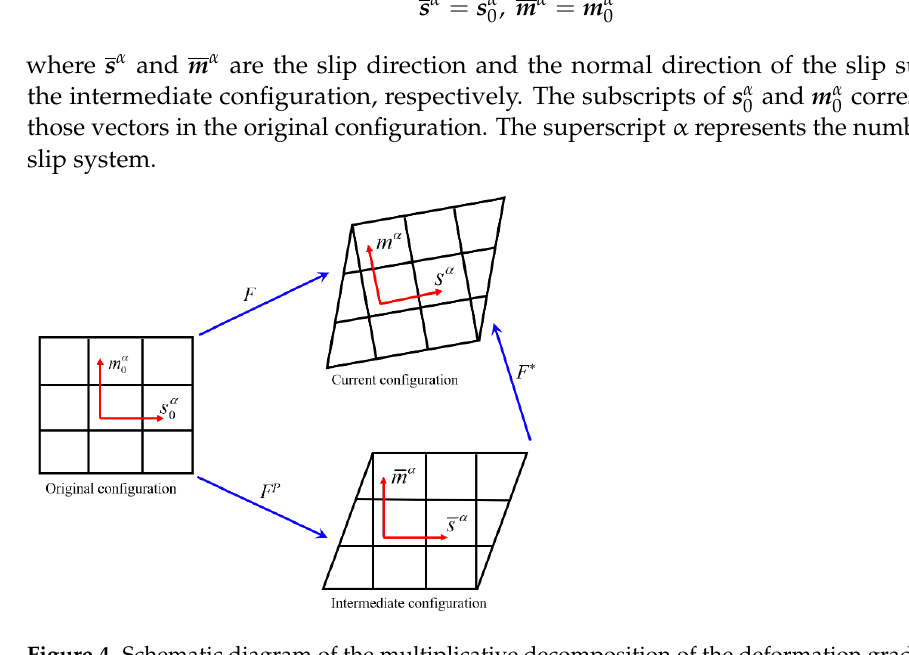
* F represents the elastic part of the deformation gradient. It